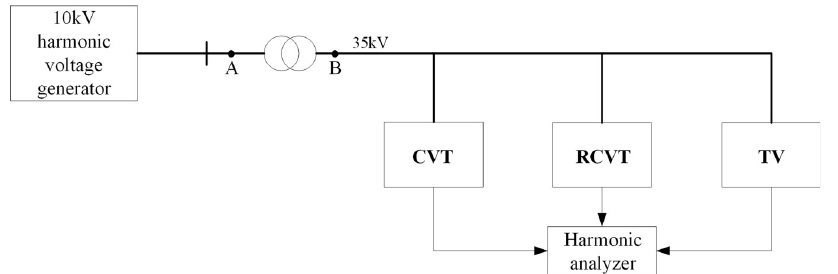
Fig 9. Structure of the experimental platform with a step-up